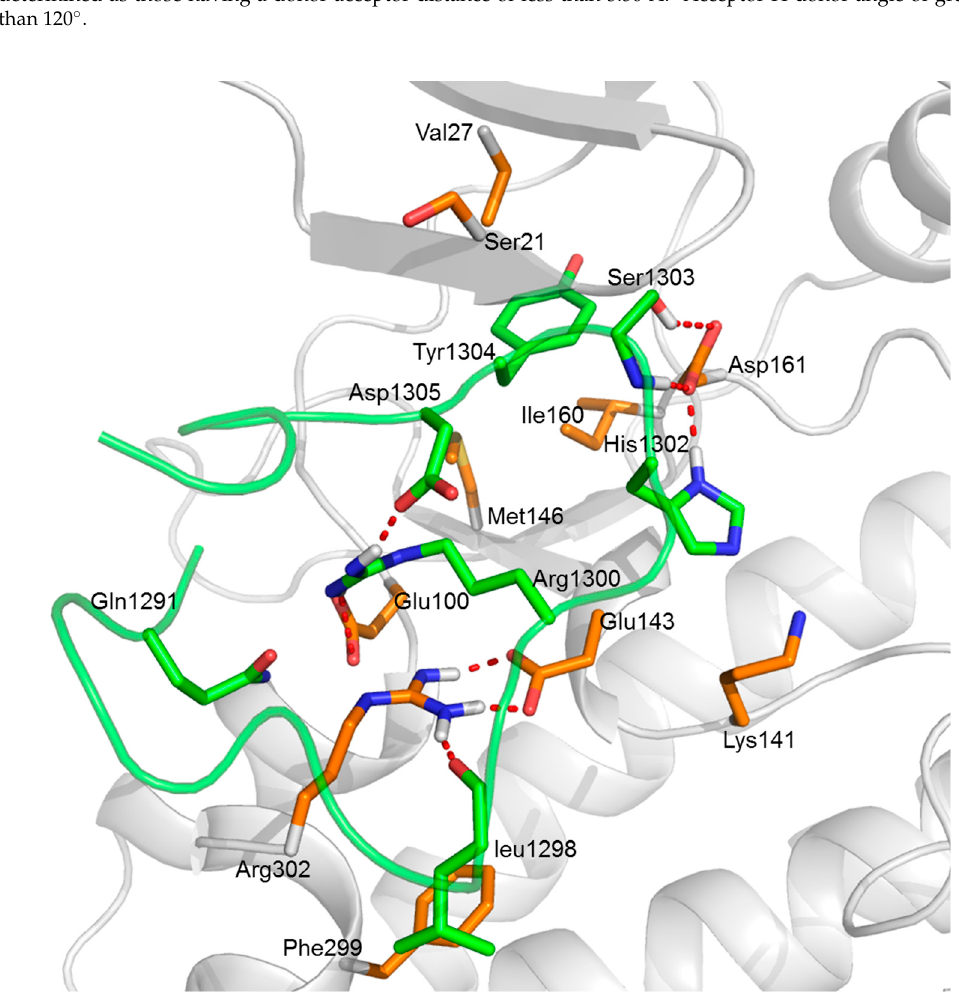
Figure 7. The predicted key interactions between the DAPK1 protein and the GluN2B-CT 1290–1310 peptide in predicted complex 1 . The DAPK1 is shown as a grey cartoon while the GluN2B-CT 1290–1310 is shown as a green cartoon. The C-terminal residues of the DAPK1 and the GluN2B-CT 1290–1310 binding site residues are represented by orange and green sticks, respectively. The red dashed lines represent the hydrogen bonds.